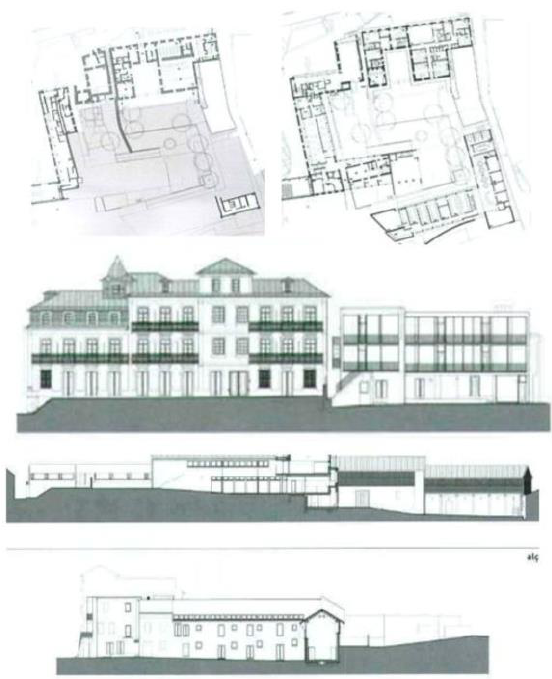
Figure 5. Architectural plans for the former Casal dos Pelames together with the new spatial proposal Source: Revista Arquitectura & Vida 01-02-2007, p.